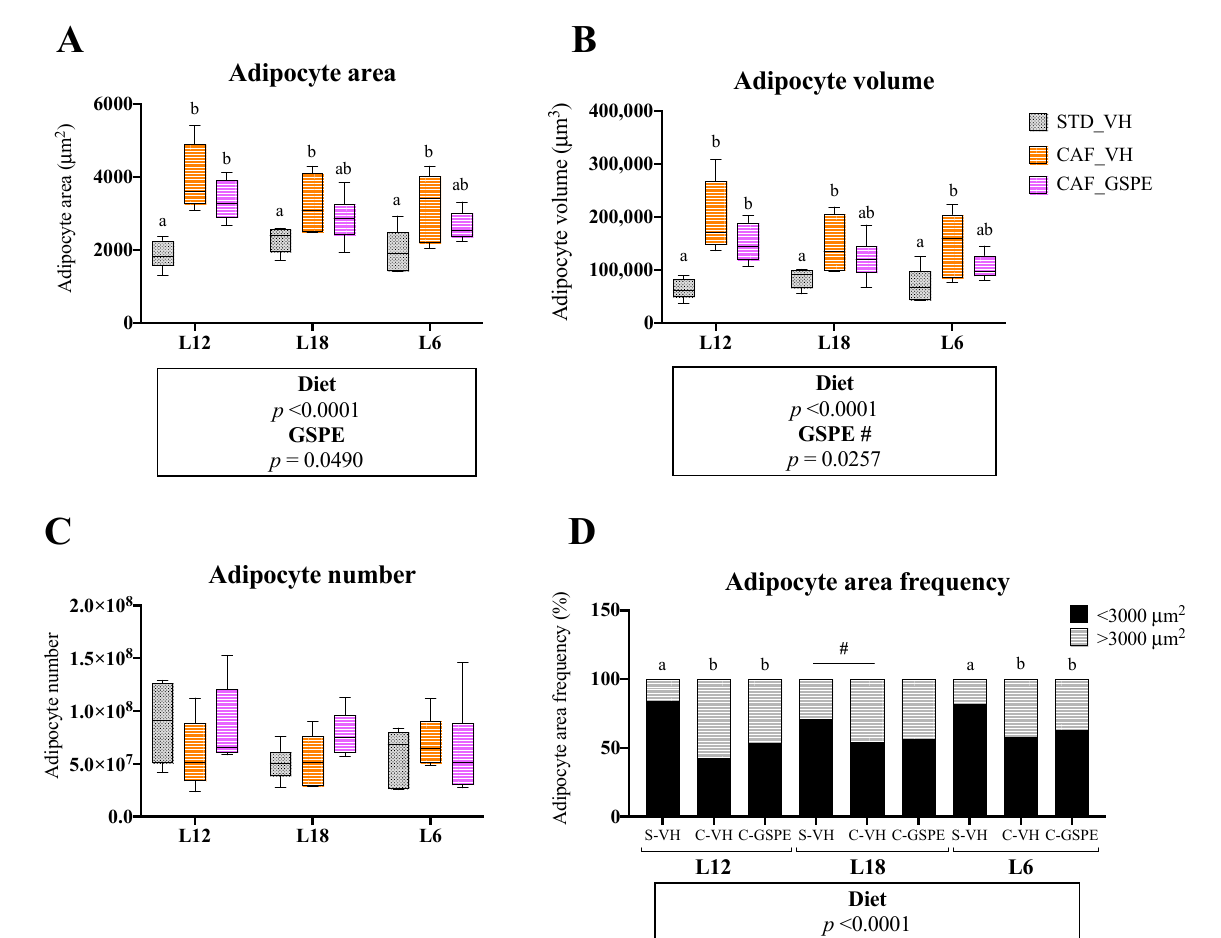
Figure 3. Adipocyte area ( A ), adipocyte volume ( B ), adipocyte number ( C ) and adipocyte area frequencies ( D ) of epididymal white adipose tissue (eWAT) of rats treated with grape seed proanthocyanidin extract (GSPE) at different photoperiods, 12 h of light:12 h of darkness (L12); 18 h of light:6 h of darkness (L18); 6 h of light:18 h of darkness (L6). Histological study of eWAT morphology of Fisher 344 rats fed with standard diet (STD) or cafeteria diet (CAF) for 9 weeks and treated with GSPE (25 mg/kg body weight) or vehicle (VH) the last 4 weeks of the study; STD-VH group; CAF-VH group; CAF-GSPE group, under different photoperiods; L12, L18 or L6. For adipocyte area frequency, adipocytes were distributed in two groups according to their areas (<3000 or >3000 μ m 2 ). The results are presented as the mean ± SEM (n = 6). Significant differences were assessed through two-way ANOVA analysis ( p < 0.05). Diet: diet effect within VH groups; GSPE: GSPE consumption effect within CAF groups; #: tendency (0.05 < p < 1). Different letters denote significant differences within each photoperiod group (assessed with one-way ANOVA followed by Tukey’s post hoc test, p < 0.05; # : tendency: 0.05 < p <